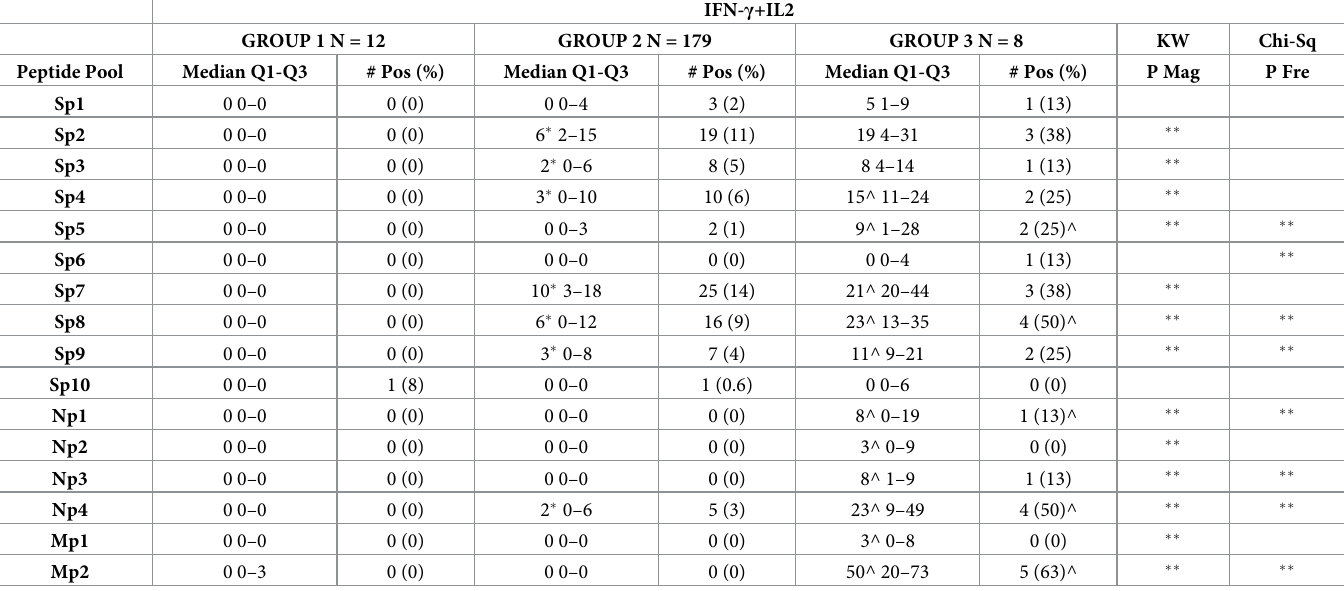
Table 4. FluoroSpot IFN- γ +IL2 responses to individual S, N and M peptide